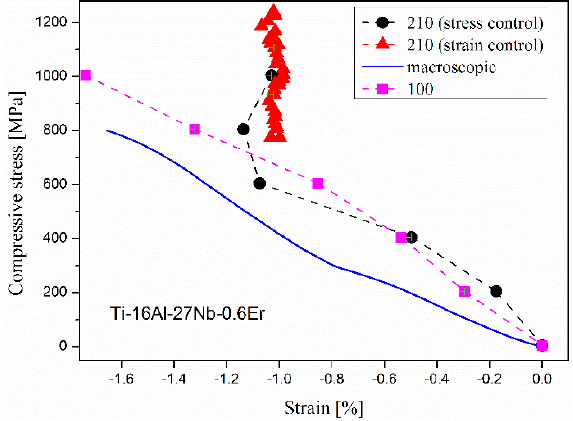
Figure 4. Lattice strain along (210), (100) and compressive macroscopic strain as a function of applied stress. All the error bars are smaller than the symbol size in the figures.